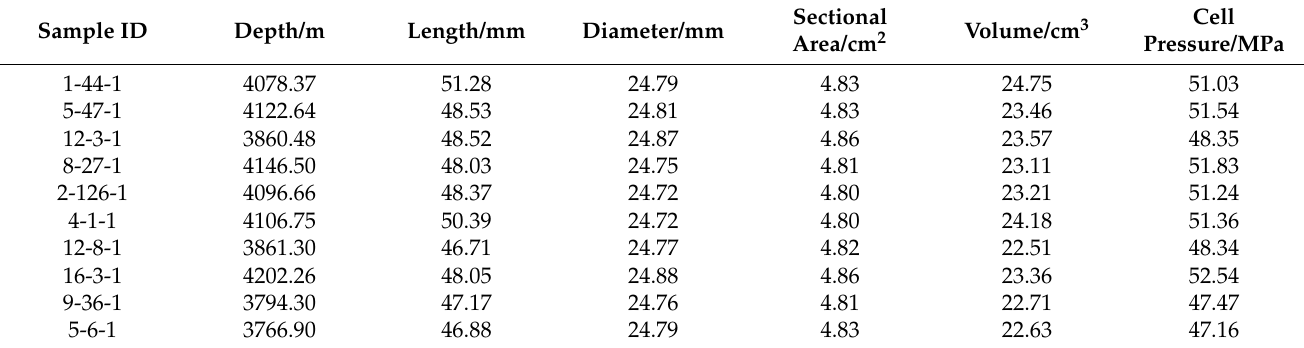
Table 2. Core plug samples and tested